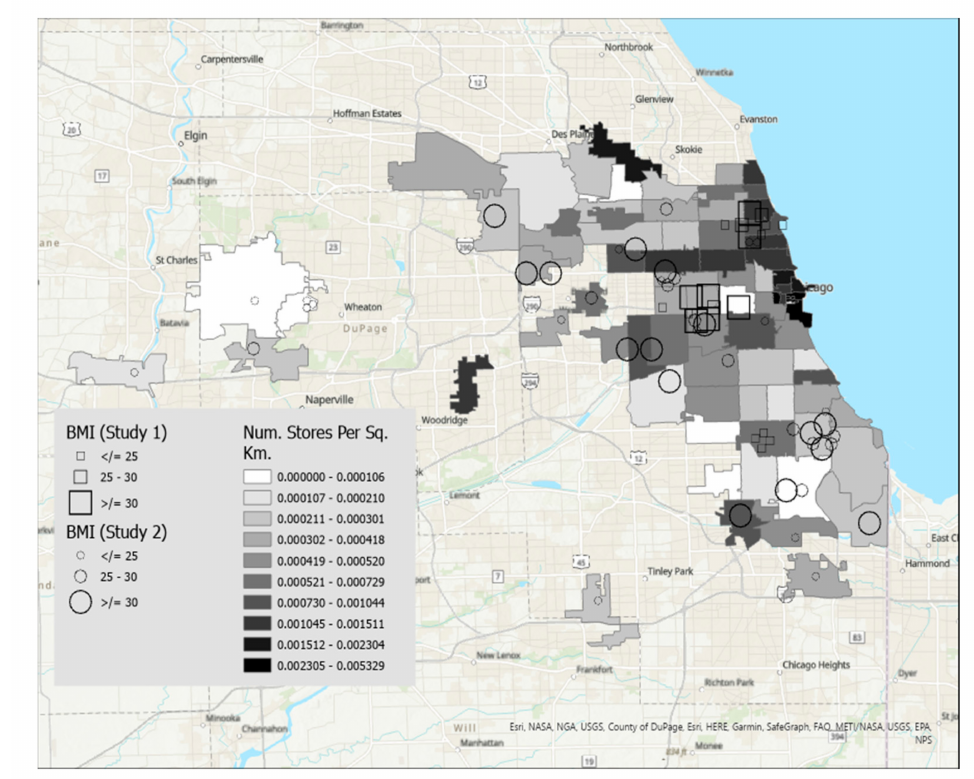
Figure 4. This figure displays BMI overlaid on a map of store density (darker shade indicates higher density). A pattern emerged such that participants with higher BMI tended to live in the south and west sides of Chicago, which have a relatively lower concentration of grocery stores in the city. Participants who lived in suburban zip codes tended to have lower BMI. Thus, city-dwelling participants with fewer grocery stores in their zip codes tended to have high